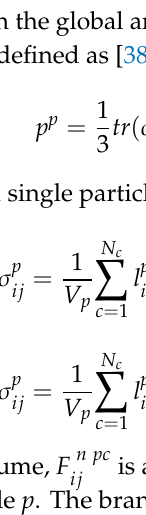
Figure 9. Percentage of contacts with Fn > 0.75 Fn aver in mixtures with various values of g.